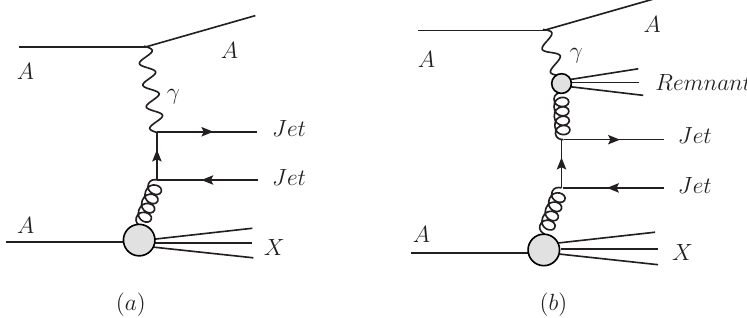
Figure 1: Typical leading-order Feynman graphs for dijet photoproduction in UPCs. Graphs (a) and (b) correspond to the direct and resolved photon contributions, re-